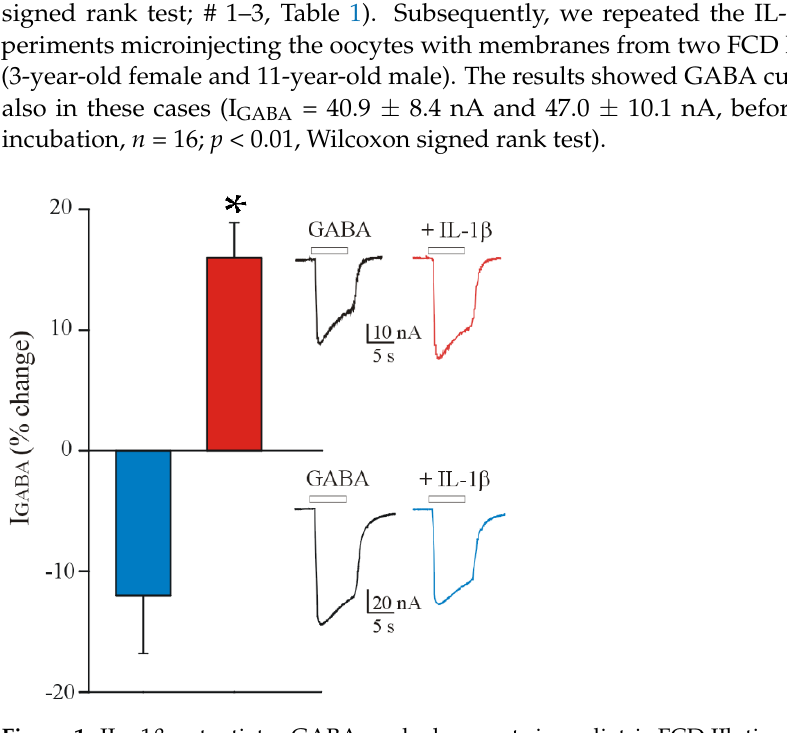
Figure 1. IL − 1 β potentiates GABA-evoked currents in pediatric FCD IIb tissue samples. The bar graphs show the average GABA current percent (%) changes ± s.e.m. before and after incubation with IL-1 β (25 ng/mL; 2 h) in oocytes transplanted with adult FCD IIb tissues (blue bar; n = 14, # 4–6, Table 1) and pediatric FCD IIb tissues (red bar; n = 31, # 1–3, Table 1). Insets represent sample currents before (left trace) and after (right trace) incubation with IL-1 β in adult (lower inset) and pediatric (upper inset) FCD IIb. White horizontal bars represent GABA application (250 µ M). There is a significantly different effect of IL-1 β between the two experimental groups. * p < 0.05 with Student t -test.